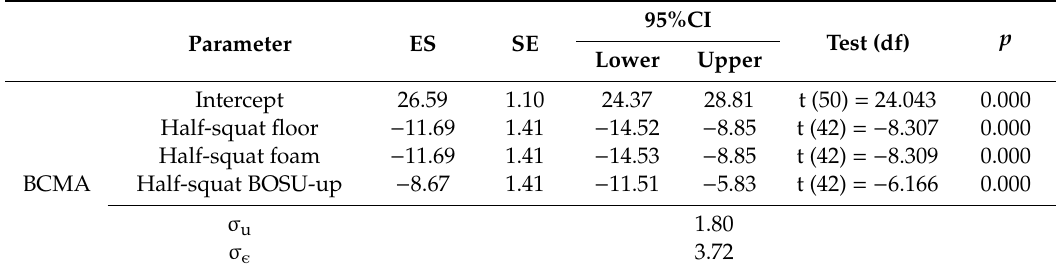
95%CI Test (df) p Lower Upper